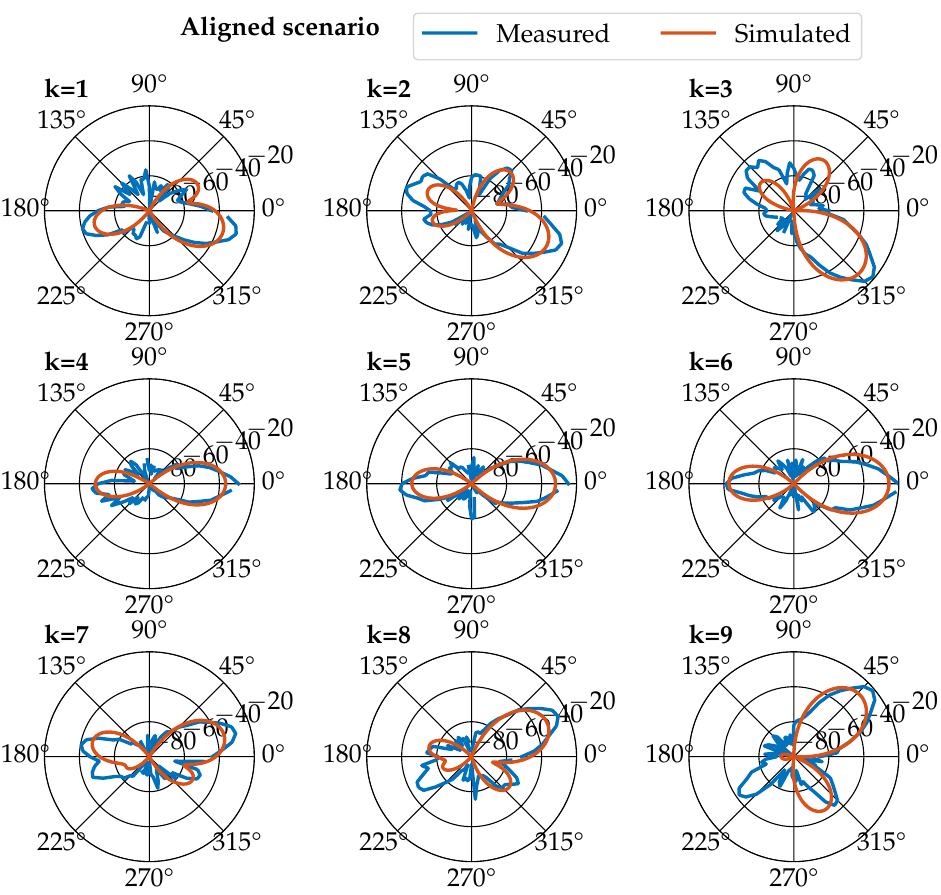
Figure 1. Power patterns. Sub-figures are positioned relative to each other to indicate RX positions in the room